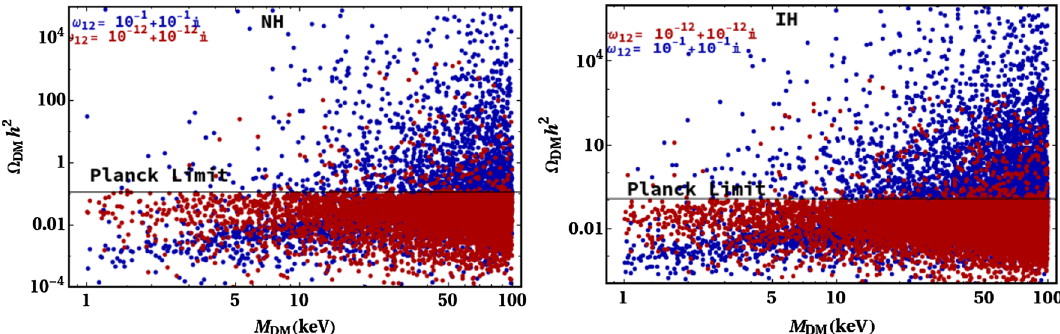
Fig. 7 The plot shows variation of relic abundance w.r.t the dark matter mass for NH/IH. Two different values of arbitrary angle ω 12 and benchmark values of ω